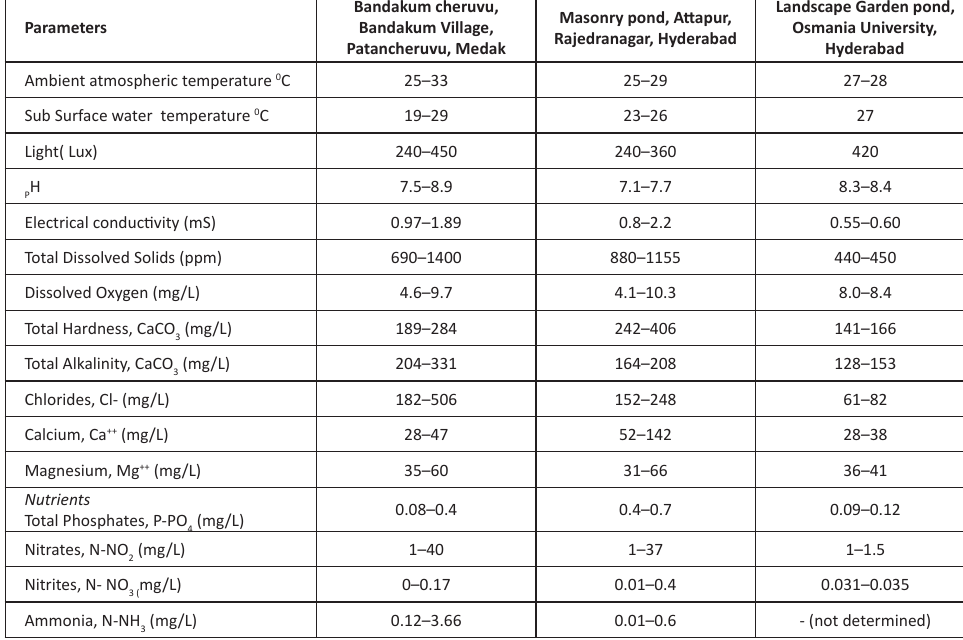
Table 2. Range of values different physicochemical parameters, in littoral surface, in three different temporary water habitats including various forms of orthophosphates and ions.